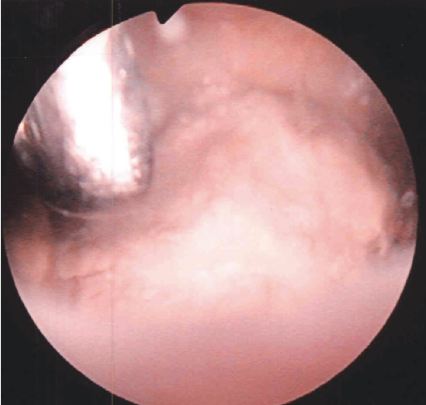
Figure1:Endoscopicappearanceofthetumor.Resectoscopereveals the tumor just before biopsy by forceps on TURBT.